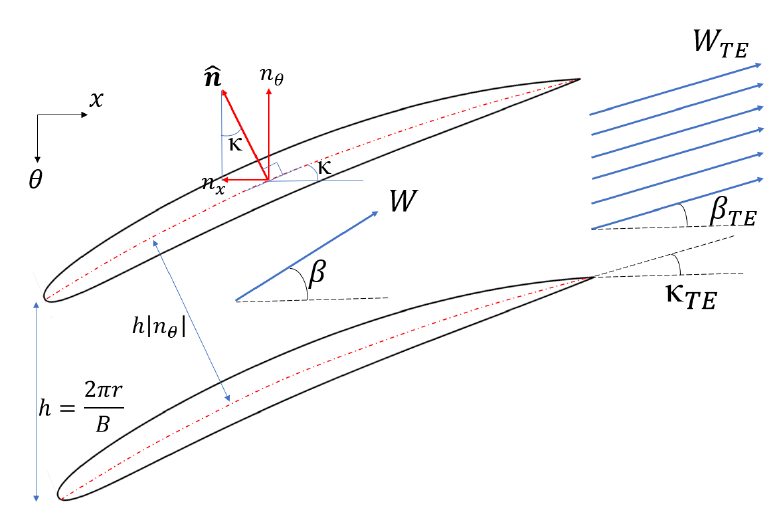
Figure 1. A schematic of flow assumptions made for the viscous loss body